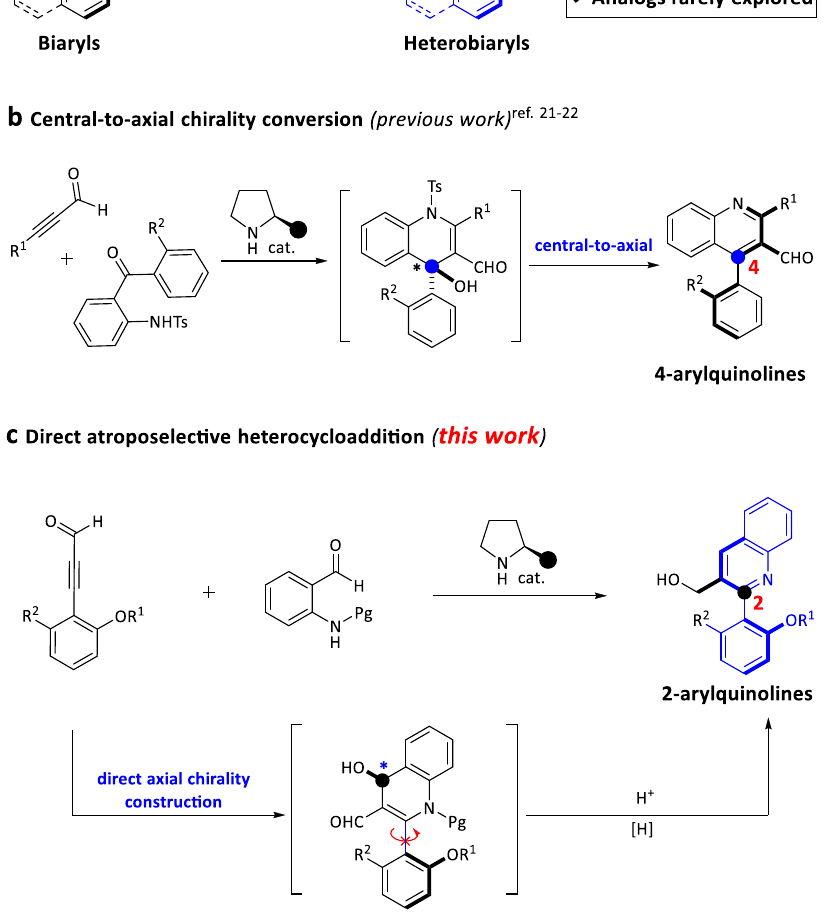
Fig. 1 Current research on axial chirality and selected molecules. a Current research status on axially chiral biaryls. b Organocatalytic synthesis of 4-arylquinolines via central-to-axial chirality conversion (previous work). c Direct to 2-arylquinolines via atroposelective cycloaddition (this